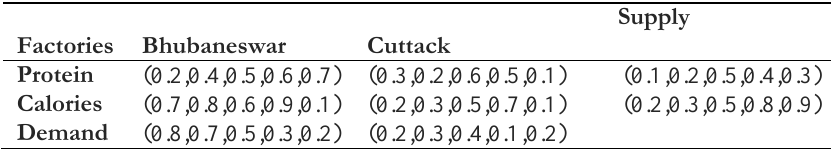
Table 12. Input data for pentagonal transportation problem.